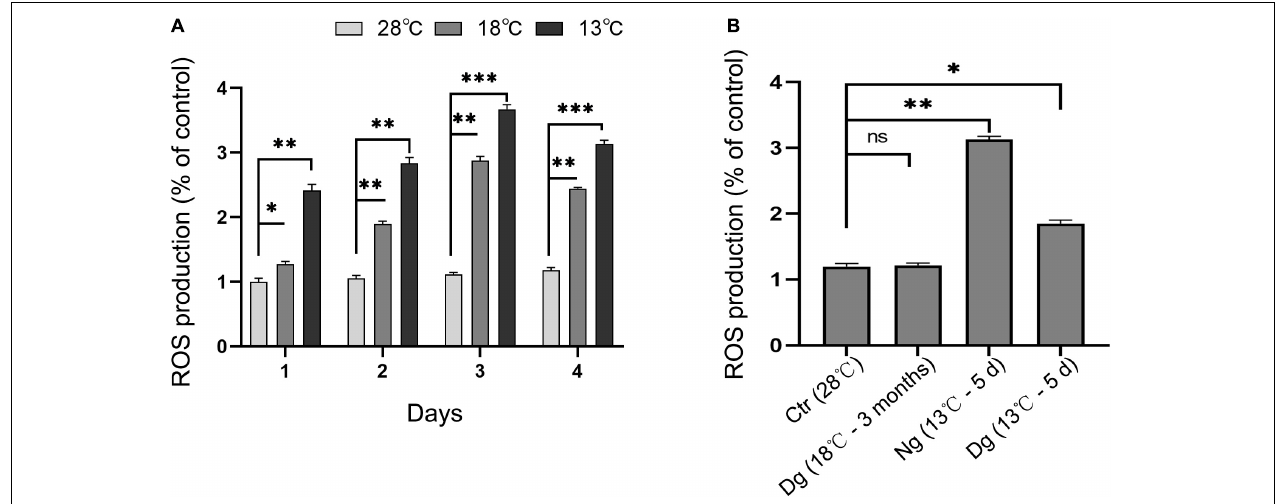
FIGURE 4 | Cold acclimation suppressed cold-induced oxidant stress in ZF4 cells. Ctr, the control group; Dg, the domesticated group; Ng, the non-domesticated group. (A,B) Cellular ROS production under cold stress. ROS was detected by flow cytometry and analyzed using FlowJo software. The results are presented as the mean ± SD ( n = 3); ∗ P < 0.05, ∗∗ P < 0.01, ∗∗∗ P <